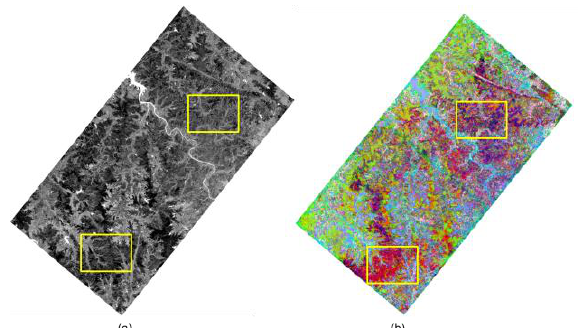
Figure 3. DESIS datasets (a) PC 3 (b) PC Indices R=7 G=4 B=3